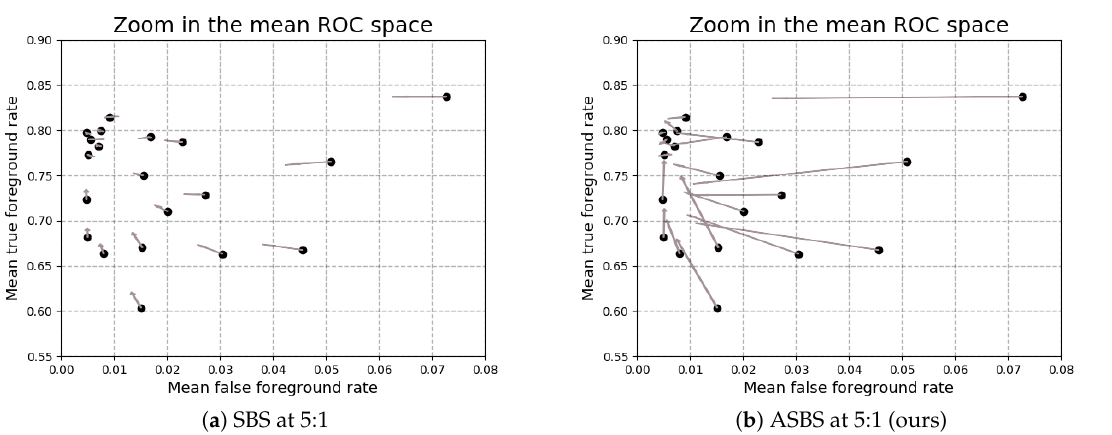
Figure 4. Overall F 1 scores obtained with SBS and ASBS for four state-of-the-art BGS algorithms and different sub-sampling factors. The performances of ASBS decrease much more slowly than those of SBS with the decrease of the semantic frame rate and, therefore, are much closer to those of the ideal case (SBS with all semantic maps computed, that is SBS 1:1), meaning that ASBS provides better decisions for frames without semantics. On average, ASBS with 1 frame of semantics out of 25 frames (ASBS 25:1) performs as well as SBS, with copy of B t , with 1 frame of semantics out of 2 frames (SBS 2:1).